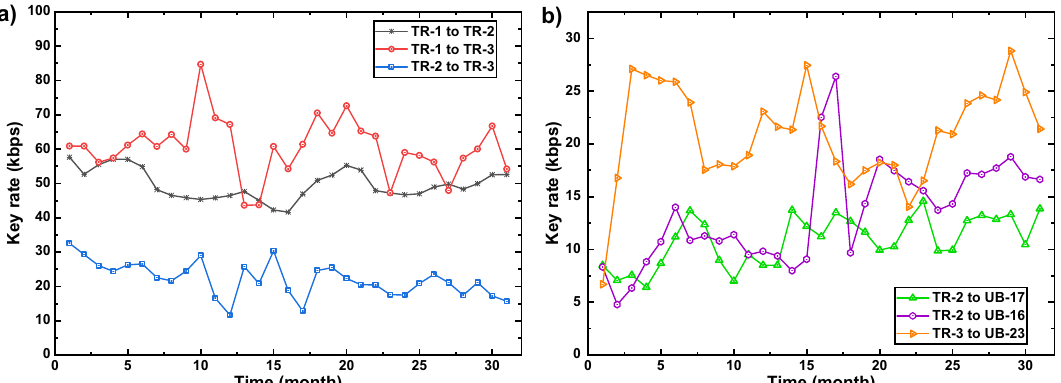
Fig. 4 The key rates versus time for some representative links. a The key rates between the three trusted relays. b The key rates between trusted relay and user. In the robustness test, 11 user nodes have continuously run for 31 months. The key rates are recorded every 30 s and taken average over a month. The detailed key rates are given in Supplementary Tables V and VI.